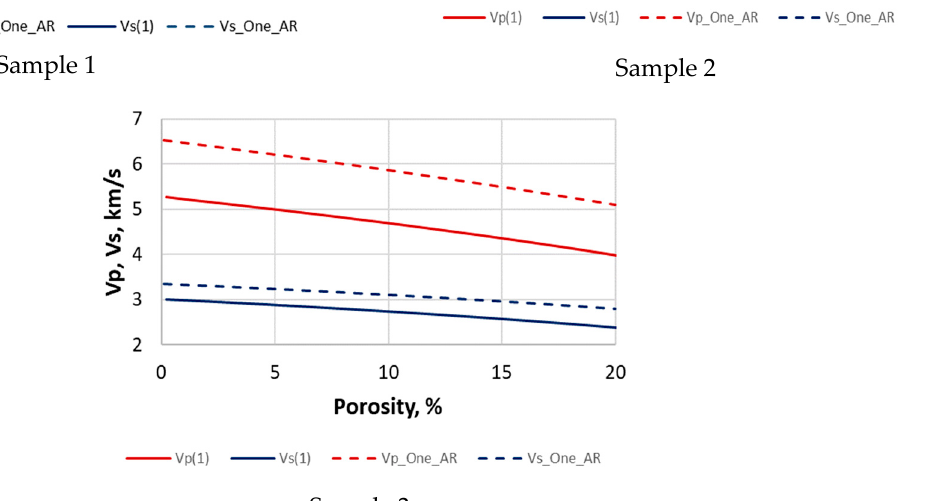
Figure 17. Comparison of the predicted values of fluid-saturated rock velocities obtained from two RP models. The solid lines correspond to the prediction based on the RP model with dual porosity (pores and microcracks). The dashed lines correspond to the RP model prediction with a single aspect ratio for all voids. The parameters of RP models are inverted from Dataset 1.